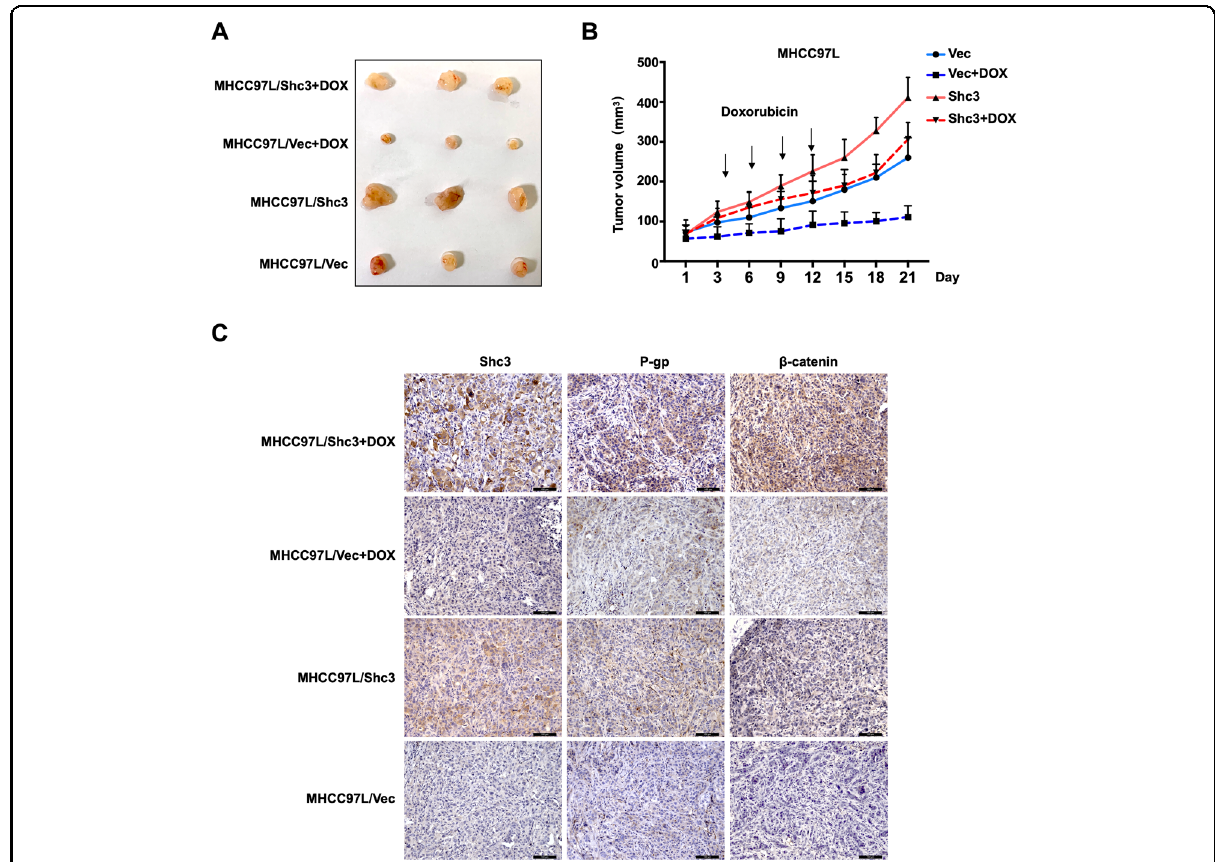
Fig. 7 Shc3 overexpression inhibits HCC sensitivity to doxorubicin in vivo. A Photographs of tumors removed from different groups of nude mice treated with doxorubicin or PBS. B Tumors growth curve of different groups that nude mice with treatment of doxorubicin or PBS. C The protein expression levels of Shc3, P-gp and β -catenin were analyzed by IHC assay of tumor tissues from different treatment groups of nude mice (representative images of IHC staining in xenograft models were shown, magni fi cations: ×200). Data are Error bars represent the mean ±